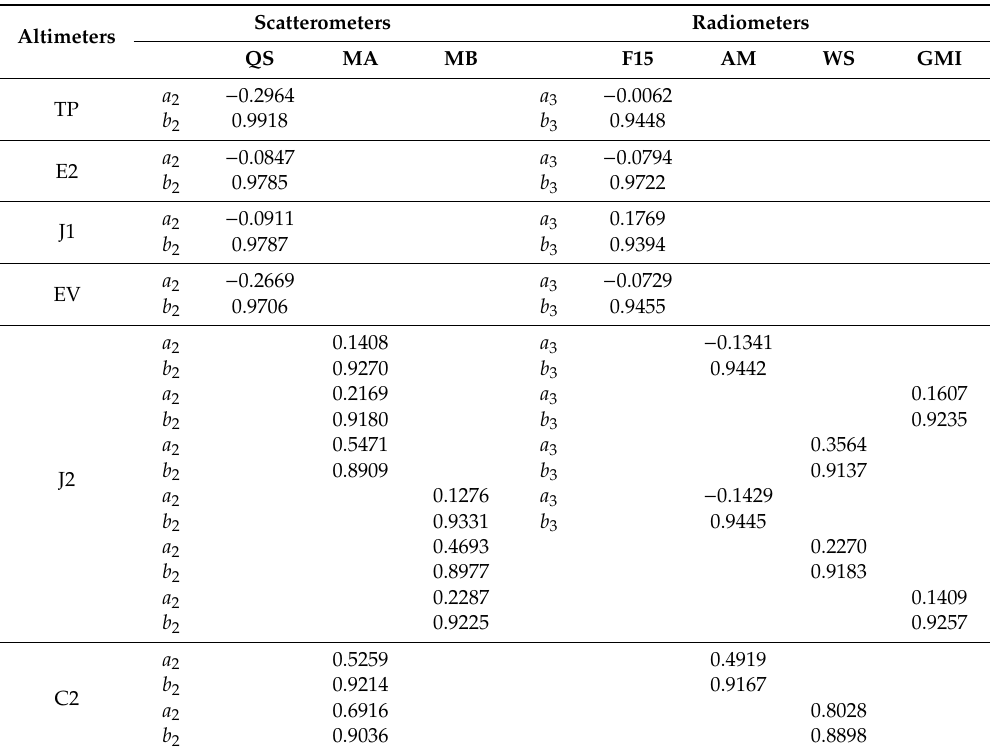
Table 3. Calibration coe ffi cient slopes ( b i ) and o ff sets ( a i ) for the triplet collocated altimeter ( X 1 ) , scatterometer ( X 2 ) and radiometer ( X 3 ) wind speed. Empty cells mean no collocation has been performed and altimeter is the reference. All other parameters as noted above.